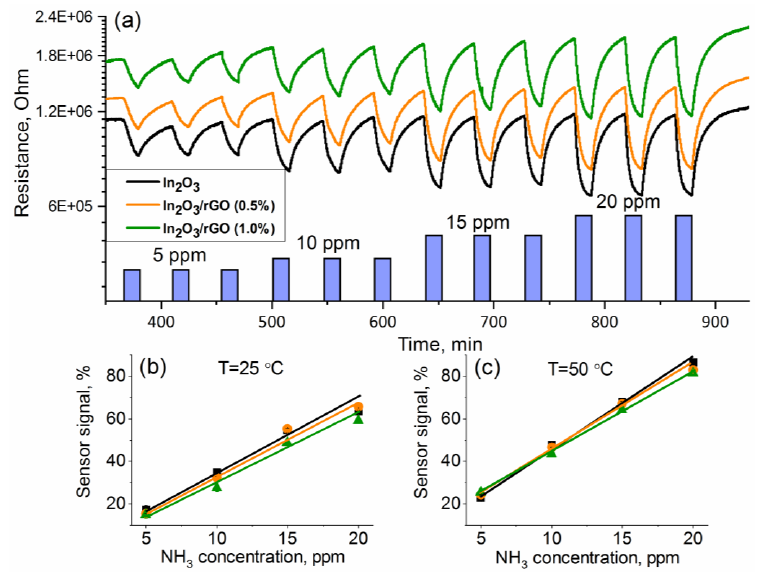
Figure 9. Change in the samples ’ resistances depending on the NH 3 concentration (5 – 10 – 15 – 20 ppm) ( a ); calibration curves at T = 25 °C ( b ) and T = 50 °C ( c ).